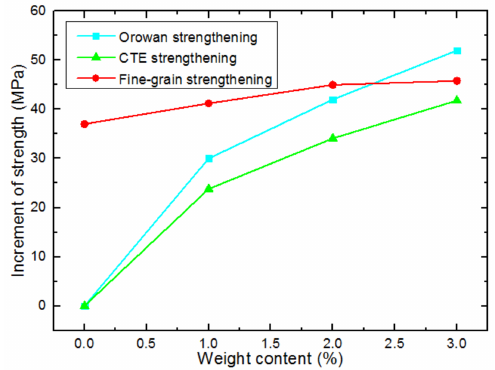
Figure 11. Calculated contribution of each strengthening